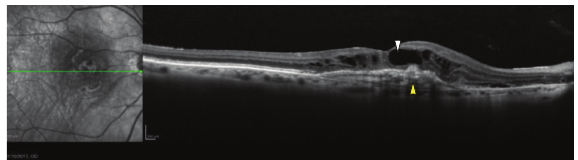
Figure 5: A line scan of an eye with macular edema secondary to an active exudative AMD. The technique allows for visualization of the cystic spaces (white arrowhead) and other changes in the retinal layers. Note the hyperreflective layer underneath the neurosensory retina suggestive of the neovascular membrane complex (yellow